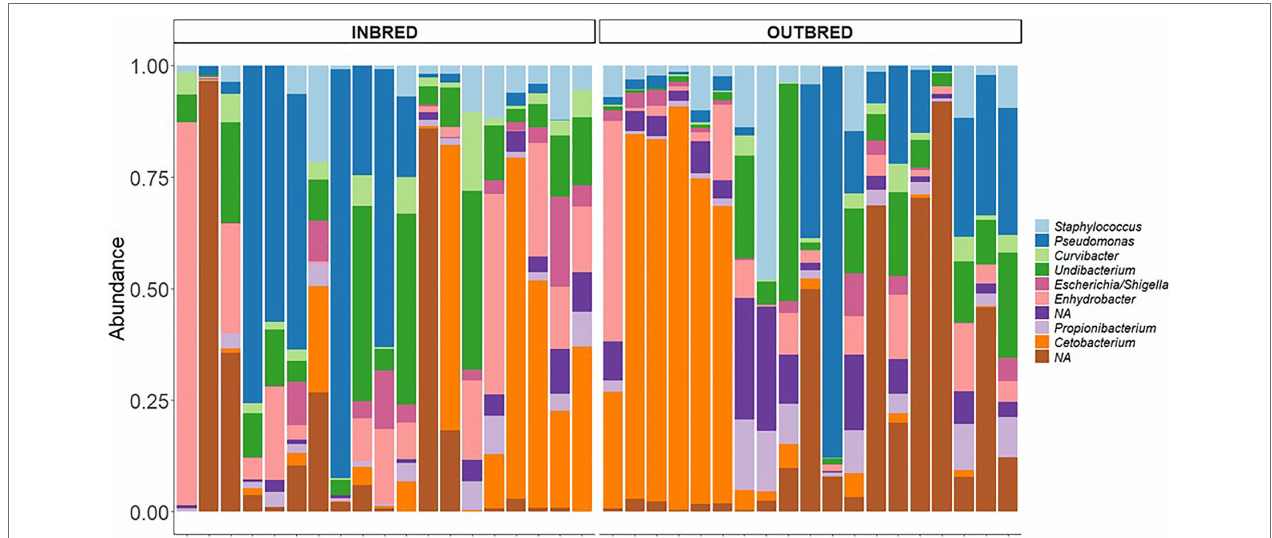
FIGURE 6 | Core microbiota in the mouth of the inbred and outbred groups of Nile tilapia. NAs: Not classified at the genus level, but at the order level, they are classified as Actinomycetales , Sphingobacteriales , in both groups.